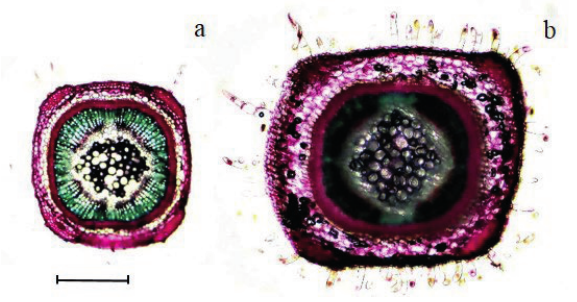
Figure 5. Comparison of the stem diameters between tetraploid (a)